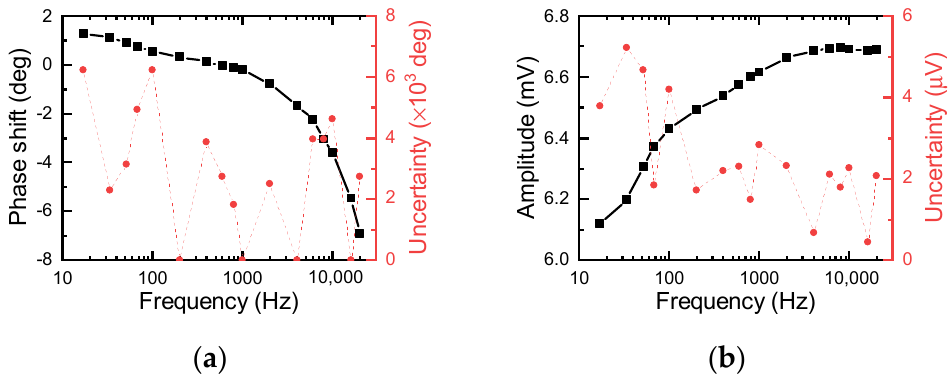
Figure 2. The calibration of a typical experimental setup for PT technique: ( a ) phase shift and ( b ) amplitude. The black square is the measured phase shift and amplitude, and the red dot denotes the measurement uncertainty of the phase shift and amplitude.